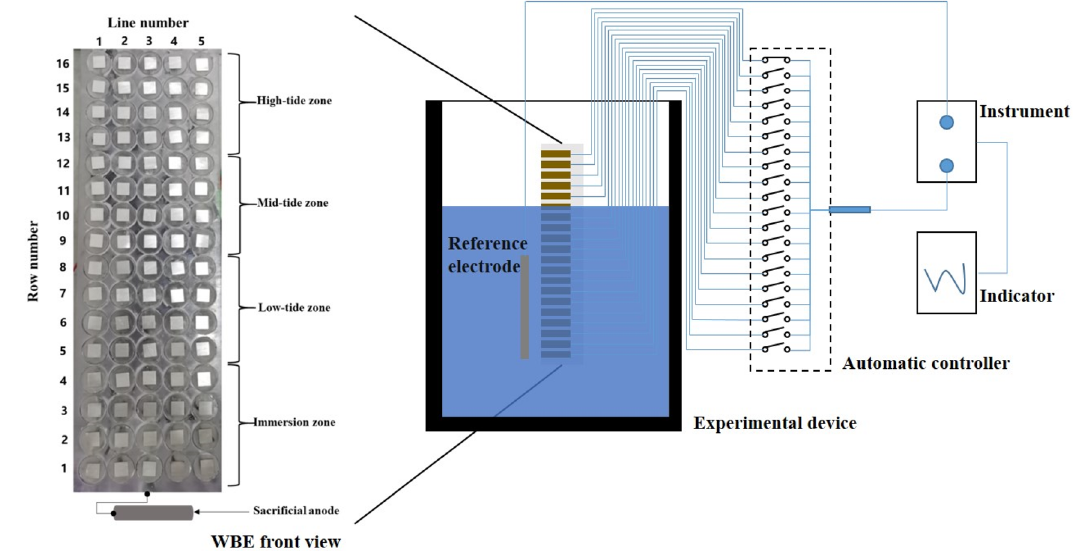
Fig. 13 WBE. The diagram of the wire beam electrode test.